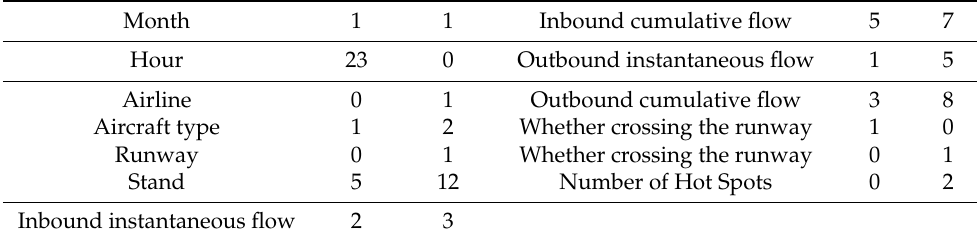
Table 4. Taxi-in time prediction model inputs.